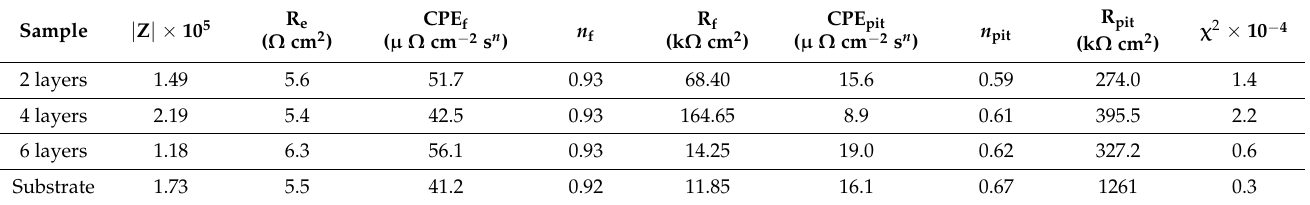
Table 5. Impedance modulus and electrical parameters calculated using the equivalent electrical